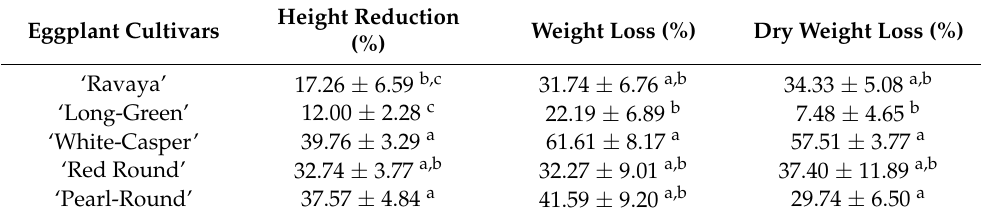
Table 4. Mean ( ± SE) reduction percentage of the growth parameters of five eggplant cultivars against Myzus persicae in the greenhouse conditions.